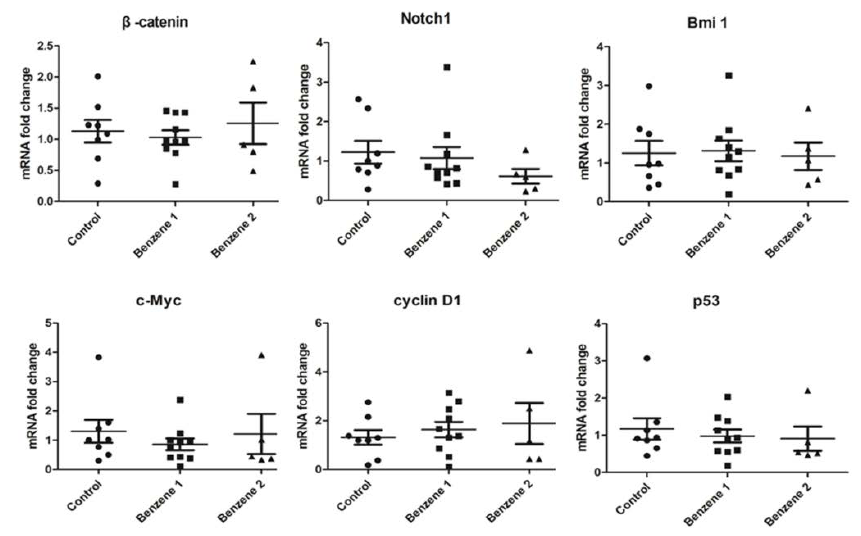
Figure 5. β-catenin, c-Myc, Notch1, cyclin D1, Bmi 1 and p53 gene expression in mouse LSK cells following 10 months post-benzene